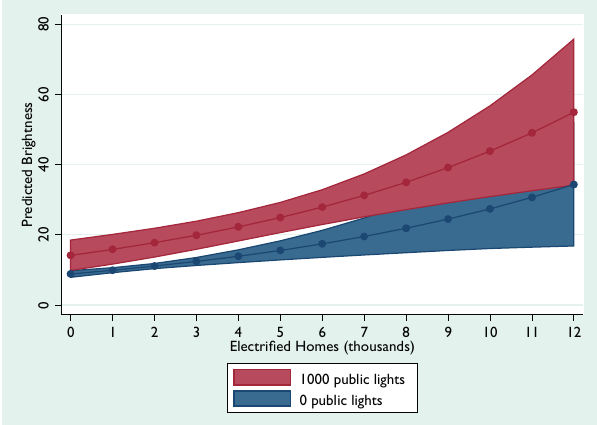
Figure 6. Brightness increases with public outdoor lights and electrified homes. Predicted values based on Table 2, Model 8 with 95% confidence